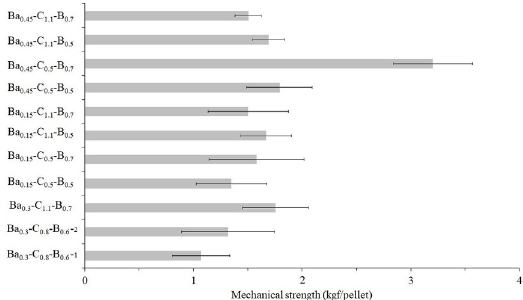
Figure 4. Influence of composition on the mechanical strength of the dried iron-ore pellets.